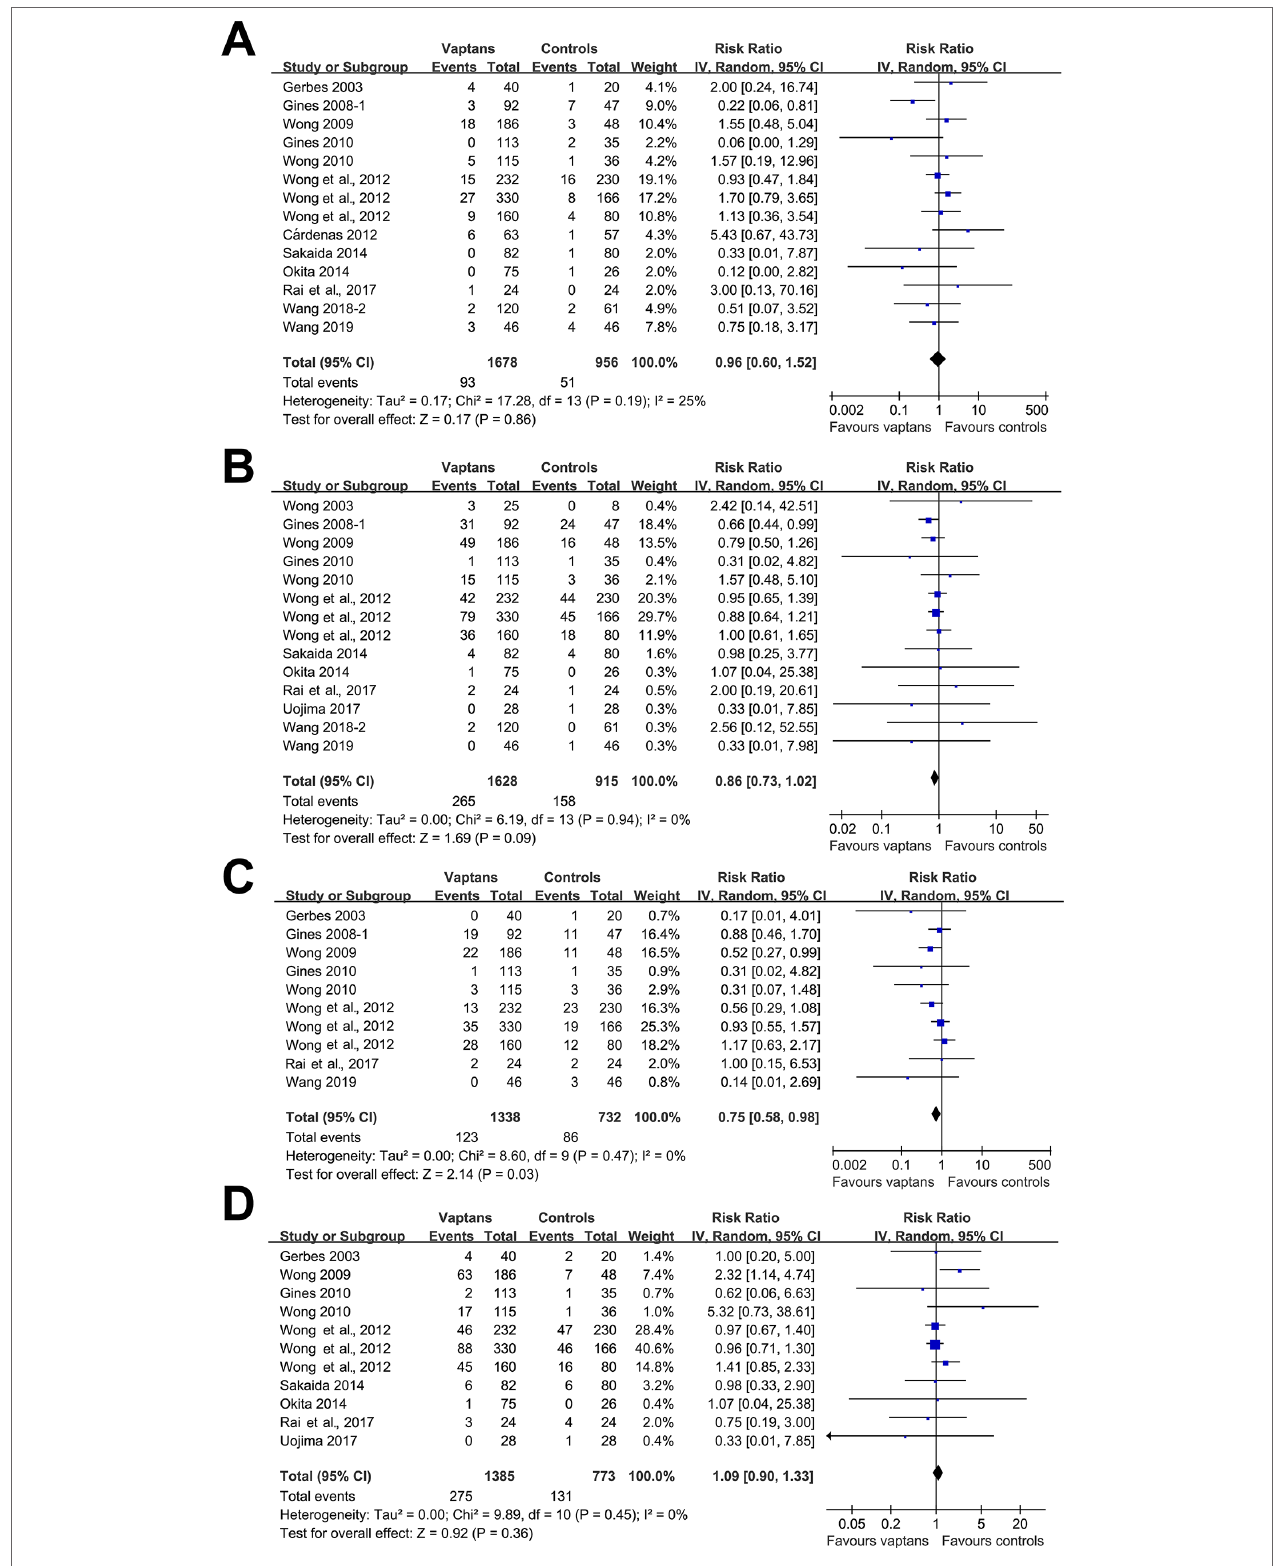
FIGURe 3 | Forest plots for meta-analysis of the influence of vaptans on the risk of ascites-related complications in cirrhosis patients. (A) Incidence of variceal bleeding. (B) Incidence of hepatic encephalopathy. (C) Incidence of spontaneous bacterial peritonitis. (D) Incidence of hepatorenal syndrome or renal failure.